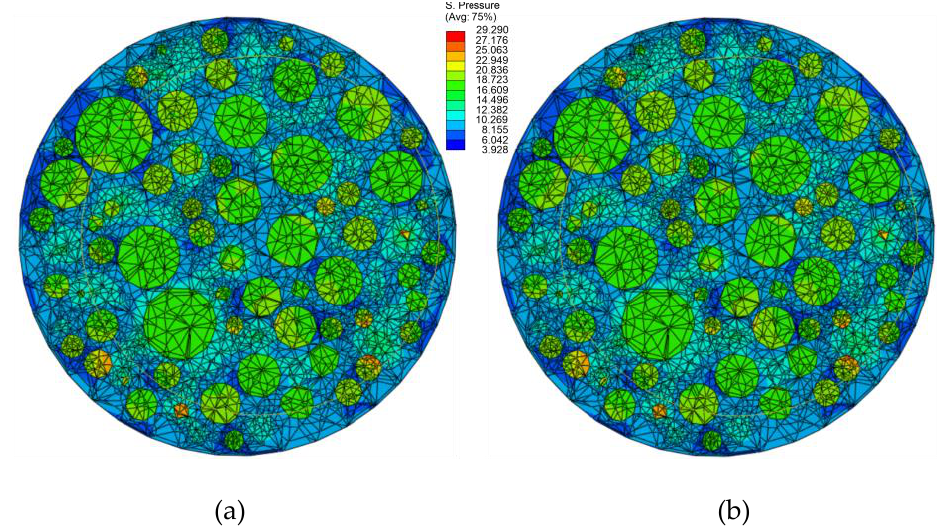
Figure 10. Sections generated by cross-section at the center of the cylinder. ( a ) 2.5 mm mesh, ( b ) 4 mm mesh.